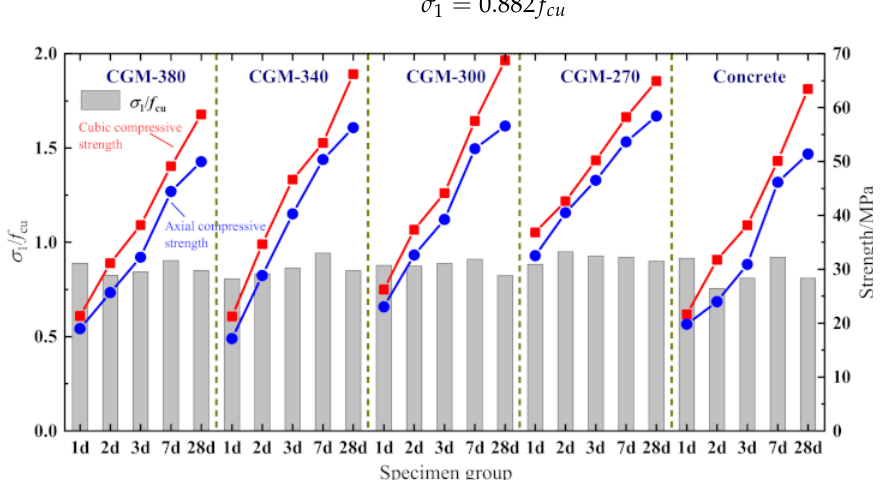
Figure 8. Ratio of axial compressive strength to cubic compressive strength.